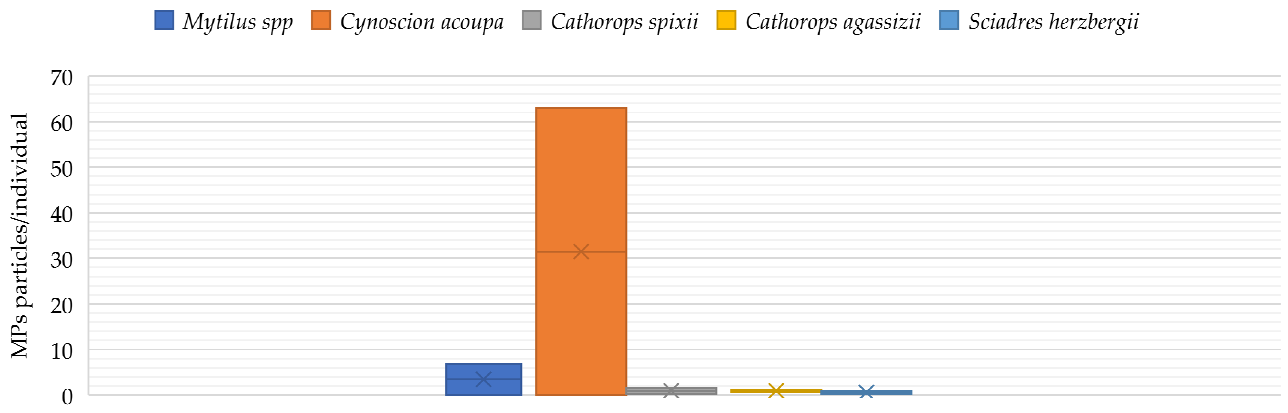
Figure 2. MP range (<5 mm) in selected marine species [45,46,48,49].